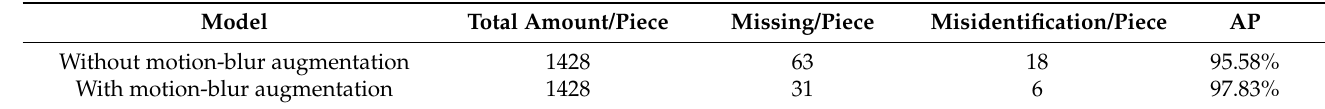
Figure 12. Motion-blurred image. ( a ) With motion-blur augmentation; ( b ) Without motion-blur augmentation. Table 3. Identification results for the cabbage field